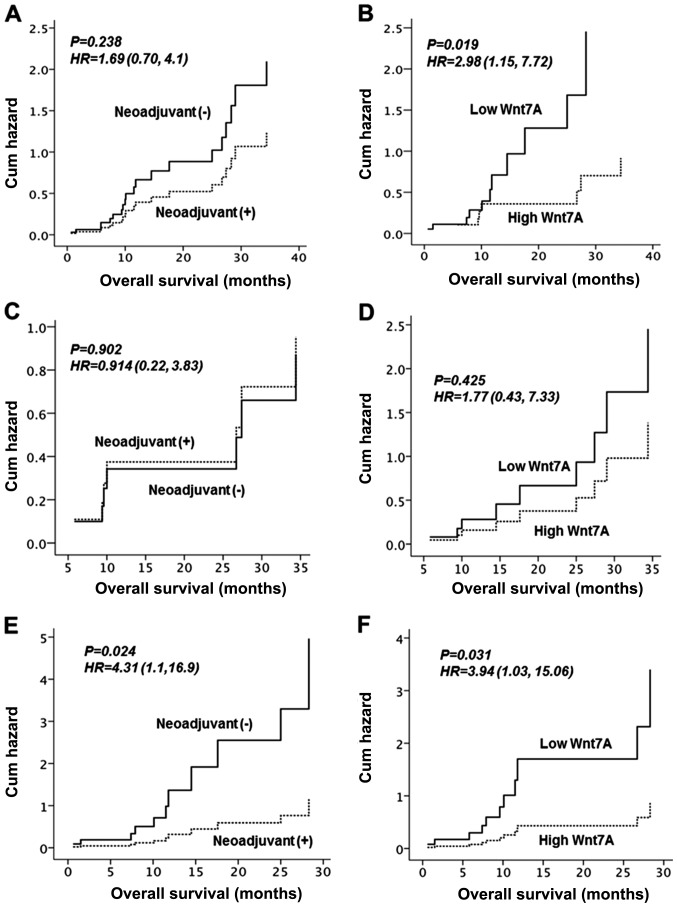
Hazard curves stratified by neoadjuvant chemotherapy and Wnt7A expression. Overall survival according to (A) neoadjuvant chemotherapy, (B) Wnt7A expression. (C) Overall survival of patients with high Wnt7A tumors according to neoadjuvant chemotherapy. (D) Overall survival of patients with neoadjuvant chemotherapy according to Wnt7A expression. (E) Overall survival of patients with low Wnt7A tumors according to neoadjuvant chemotherapy. (F) Overall survival of patients without neoadjuvant chemotherapy according to Wnt7A expression.